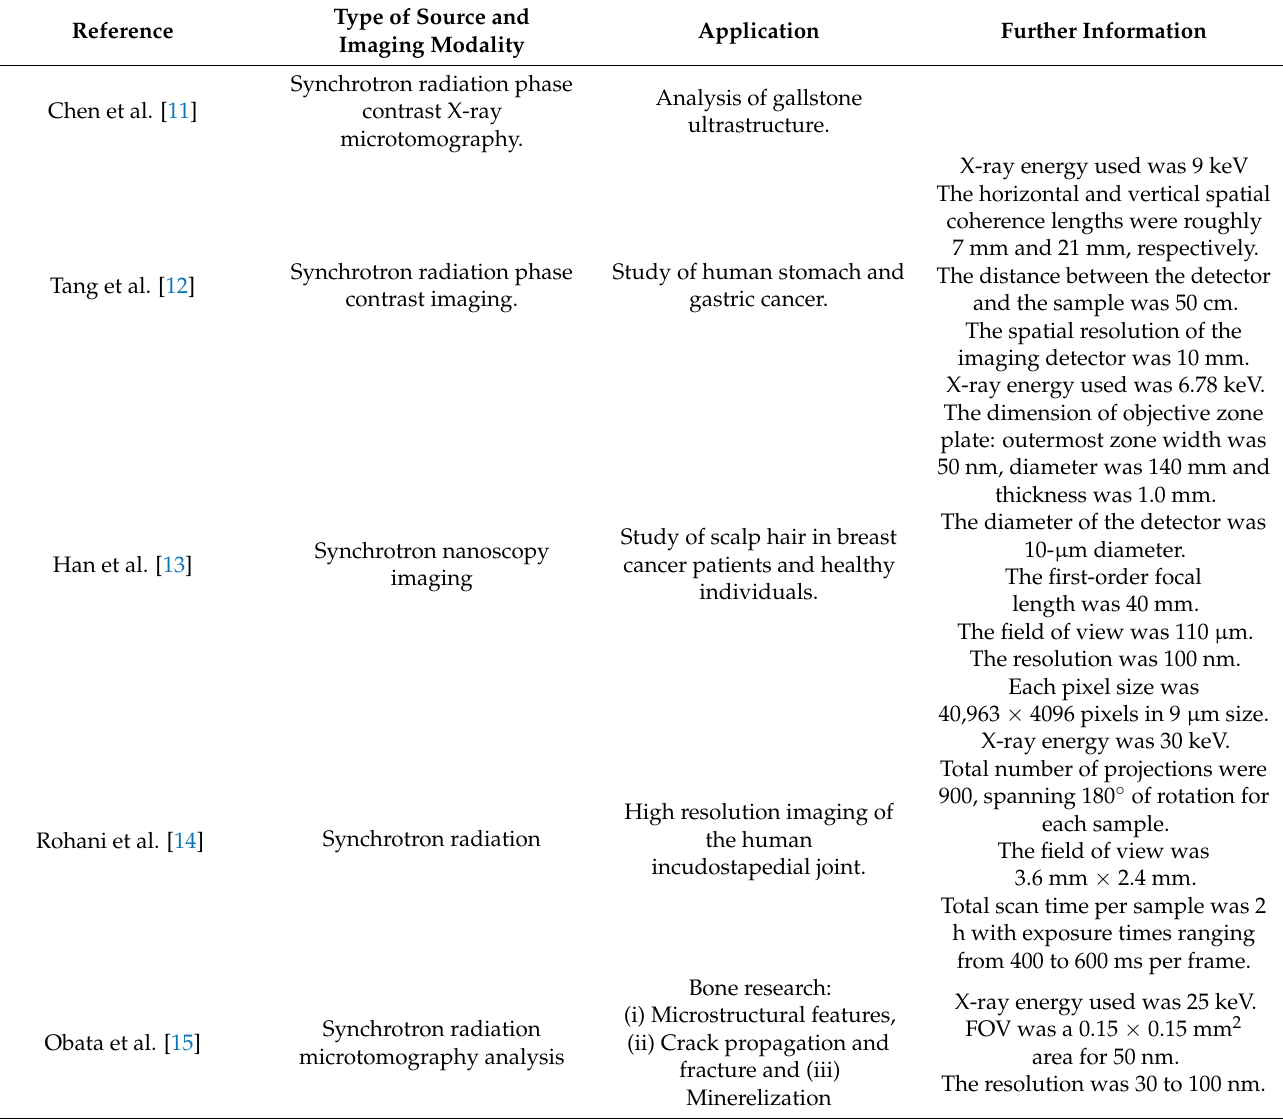
Table 1. Applications of synchrotron X-ray radiation in medical